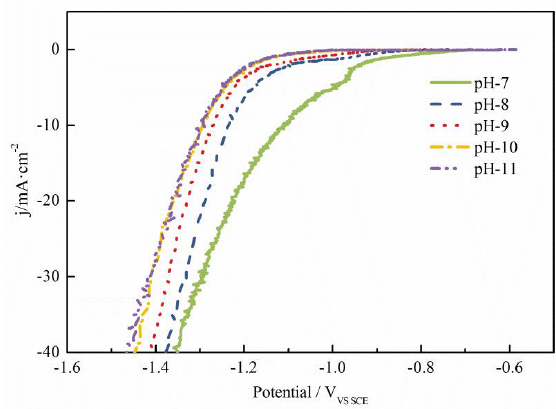
Figure 6. Linear sweep voltammograms of Co-Mo electrolytes with different pH values.